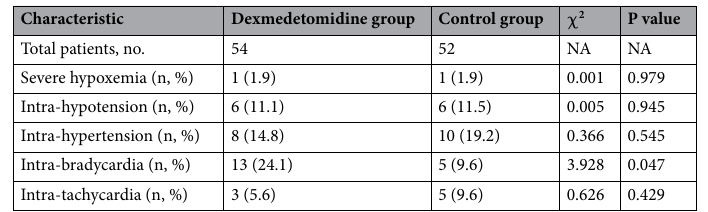
Table 3. Adverse events. NA not